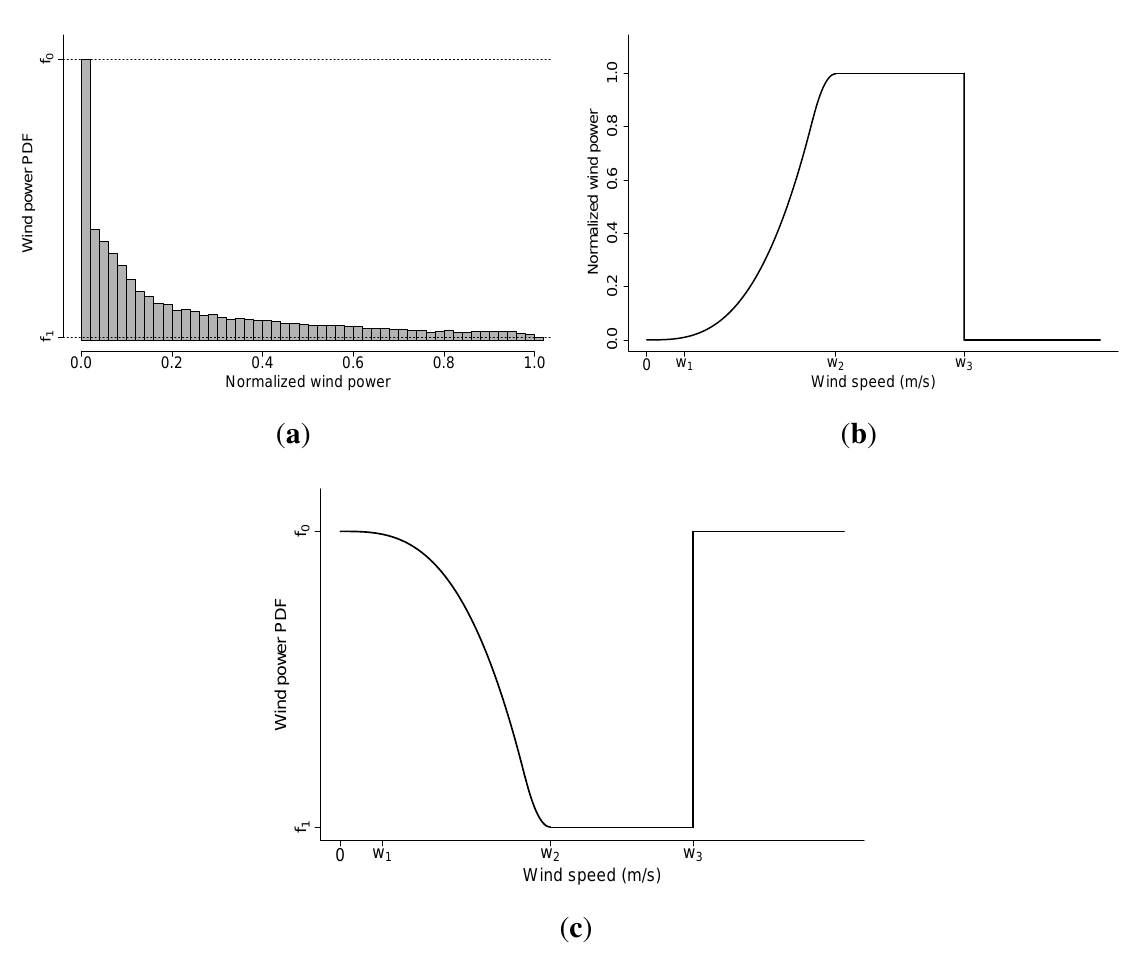
Figure 3. ( a ) Histogram of normalized wind power data ( b ) Deterministic power curve ( c ) Probability density function of normalized wind power data (PDF) versus wind